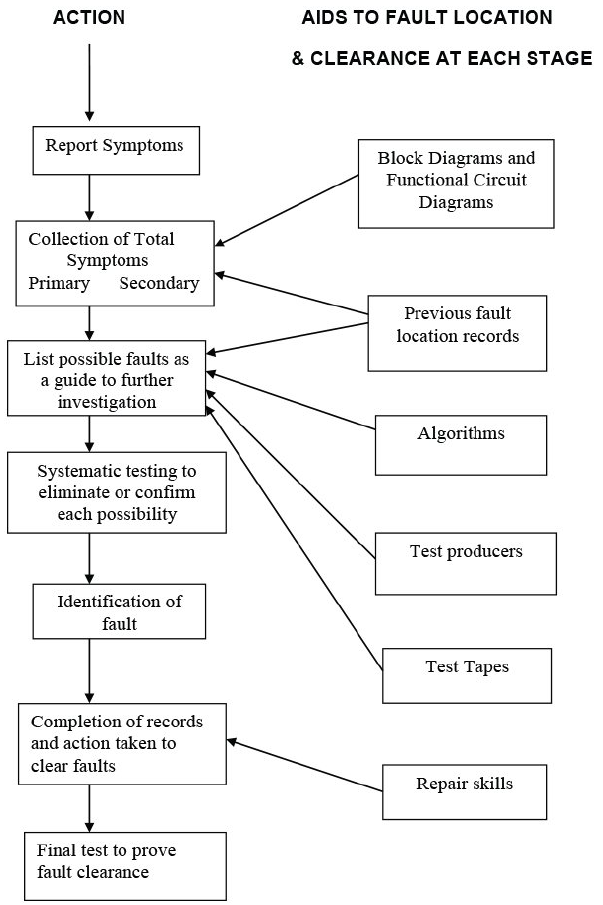
Fig. 3 Block diagram of program design.